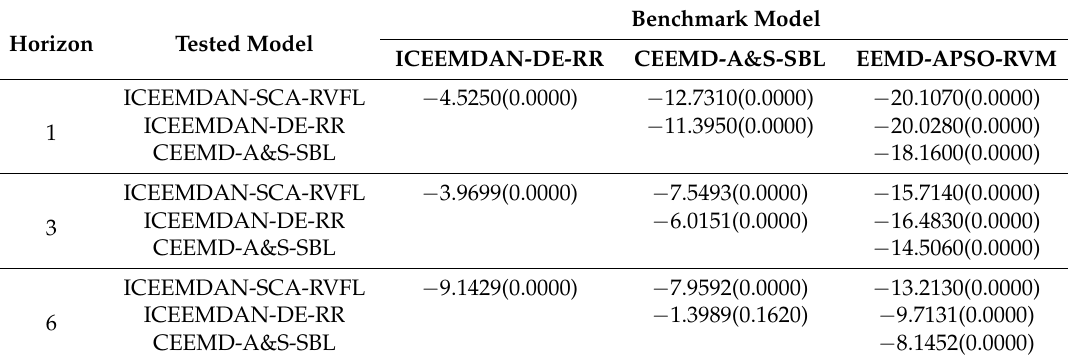
Table 7. Results of DM test of the proposed model and extant ensemble